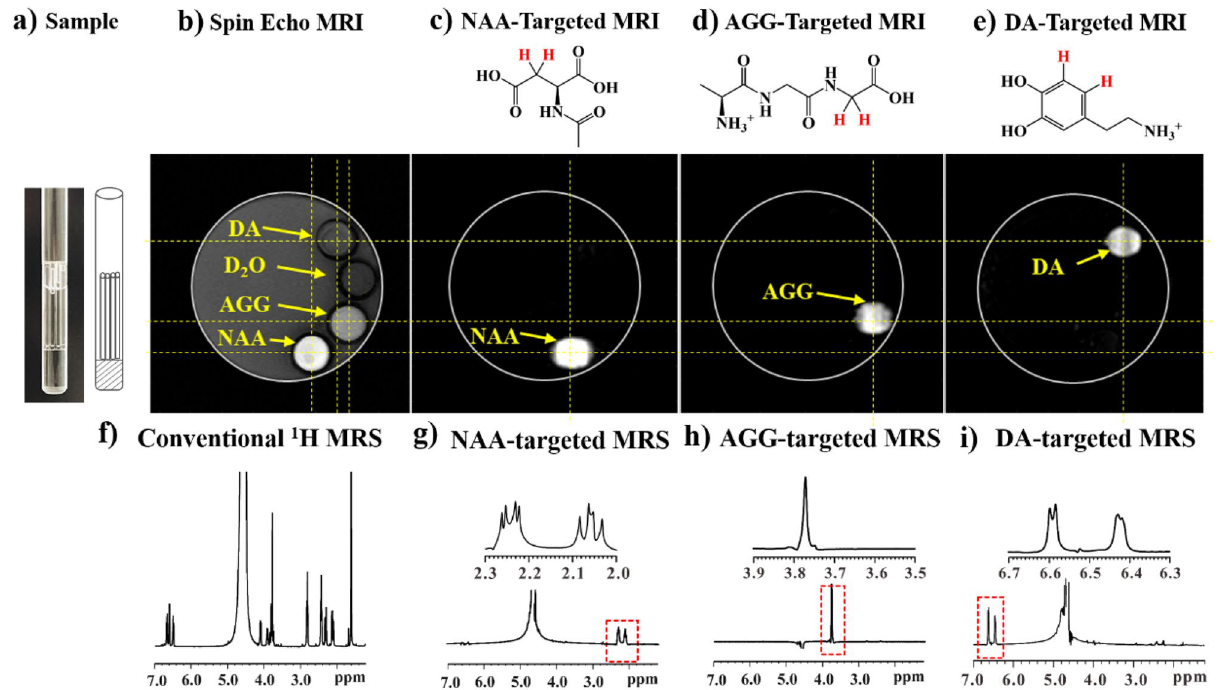
Figure 2. ( a ) A photo of the Sample 1. This sample is a 5 mm NMR glass tube containing water (40% D 2 O and 60%